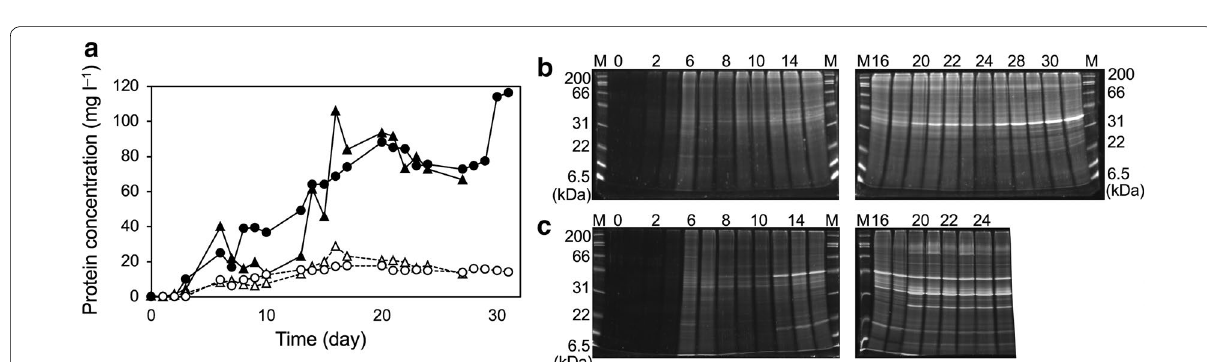
Fig. 5 Extracellular protein concentration and size distribution profiles in the activated sludge supernatants. a Protein concentrations in the sludge supernatants (closed symbols) and the effluent (open symbols). Circles and triangles denote Reactors 1 and 2, respectively. b, c SDS‑PAGE analyses of the supernatants of the activated sludge in Reactors 1 and 2, respectively. Labels on the top denote operational days or size maker (M). Labels on the left denote size of the marker